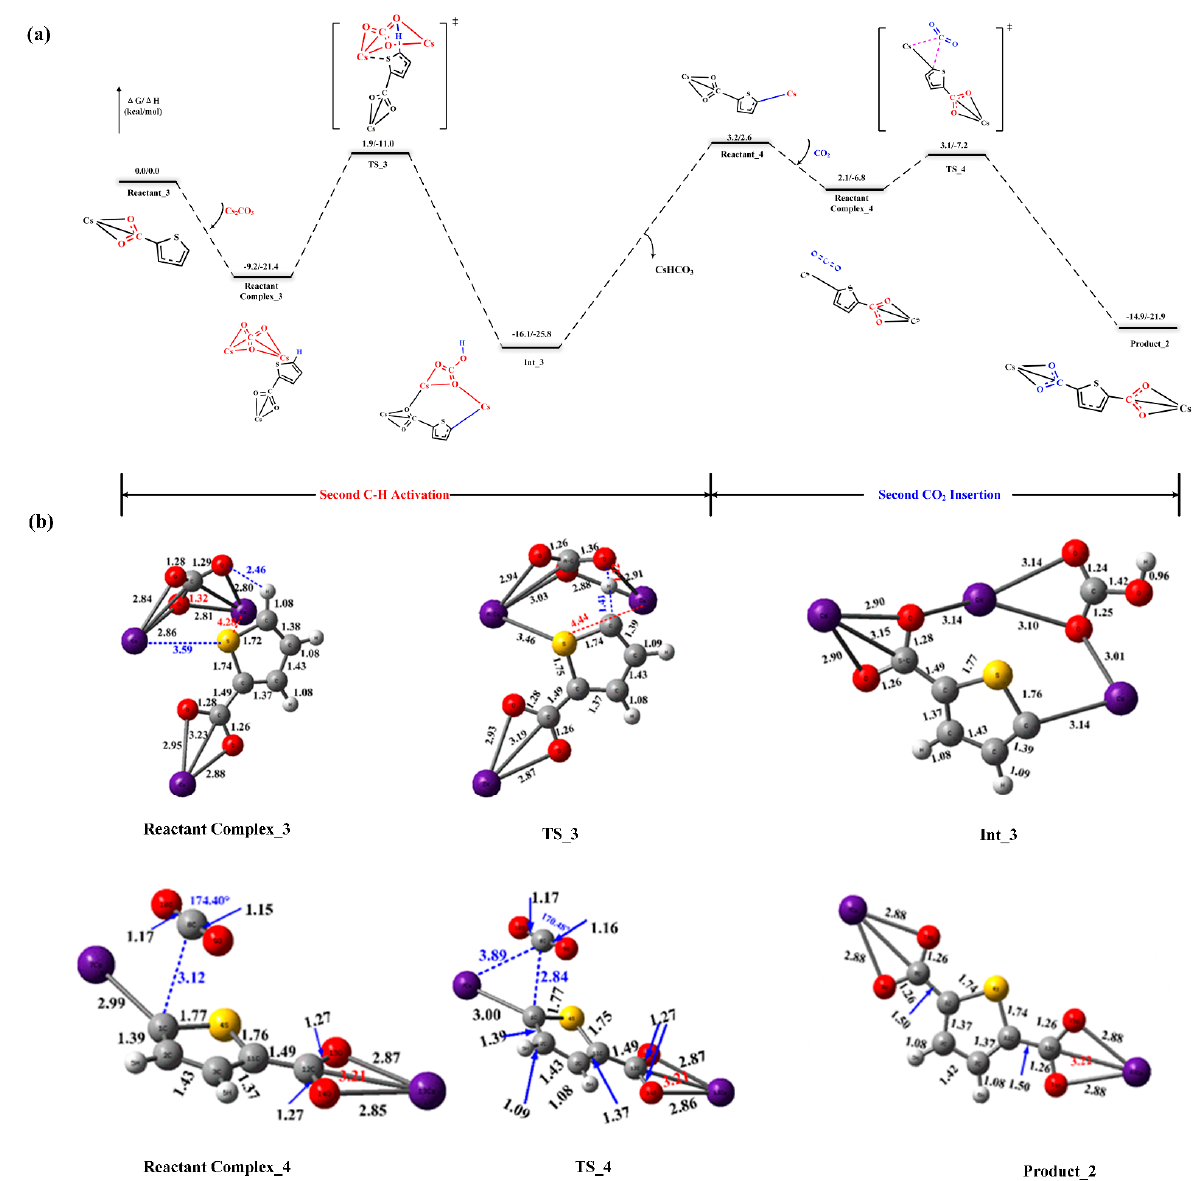
Figure 2. ( a ) Reaction energy profiles of the second carboxylation reaction. Energies are relative to the reactants of Reactant_3 and Cs 2 CO 3 . ( b ) All reported structures and their important geometric parameters (distances are in Angstroms (Å)).